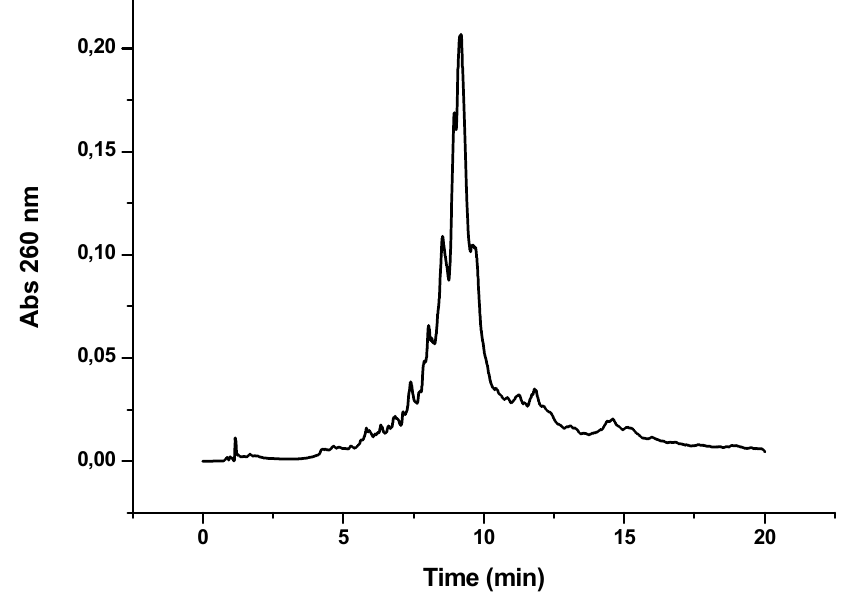
Figure 4. HPLC profile obtained after the synthesis of OPC-8 (CFFCP1Ser)-Y- TTCTTTTCTCTT). Detection wavelength 260